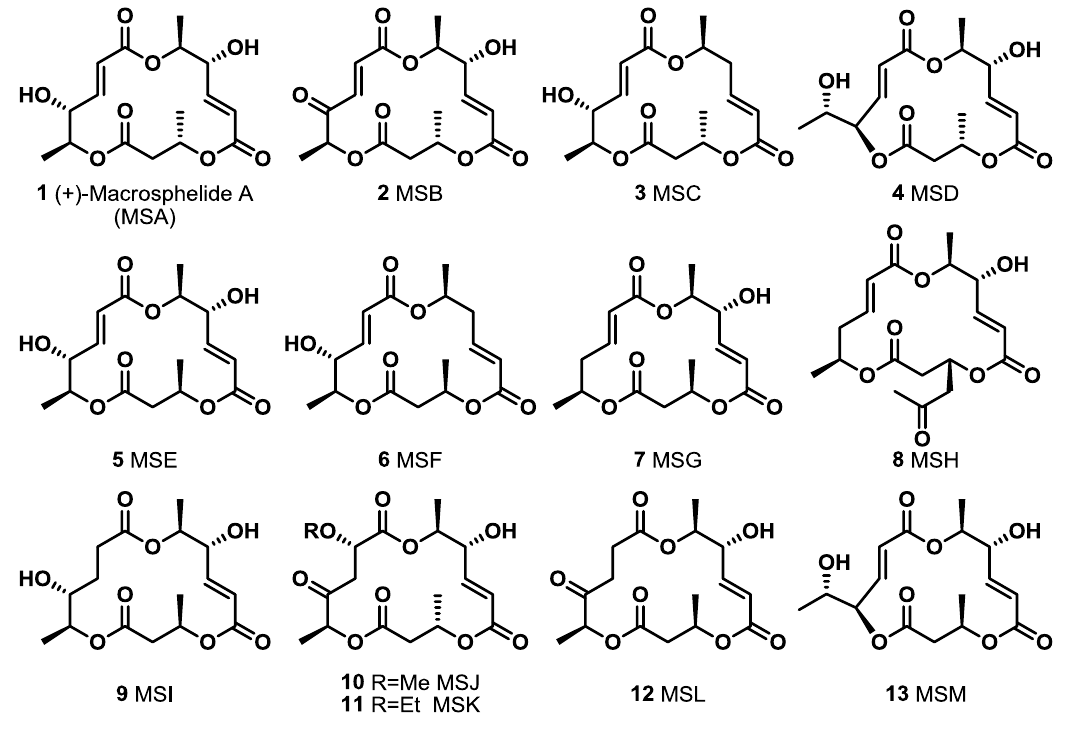
Figure 1. Natural